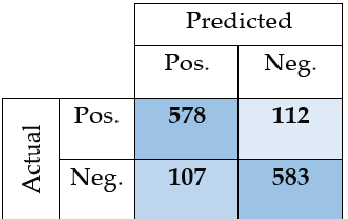
Figure 7. Confusion Matrix for the final winning model. Table 7. Comparison with recent sentiment analysis